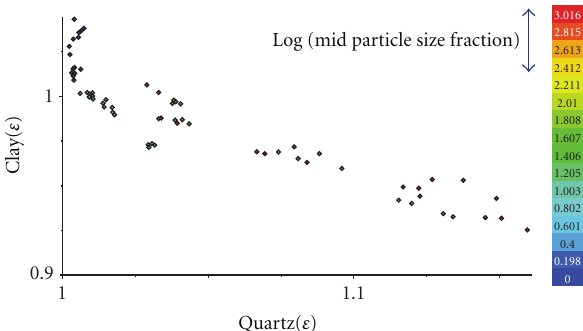
Figure 7: Relationship between quartz and clay content spectral parameters colour coded by the log of the particle size (e.g., red > 2.8 or ∼ 60 μ m–2mm; blue < 1 or ∼ < 2 μ m), showing the inverse relationship between TIR interpreted quartz and clay mineral contents.